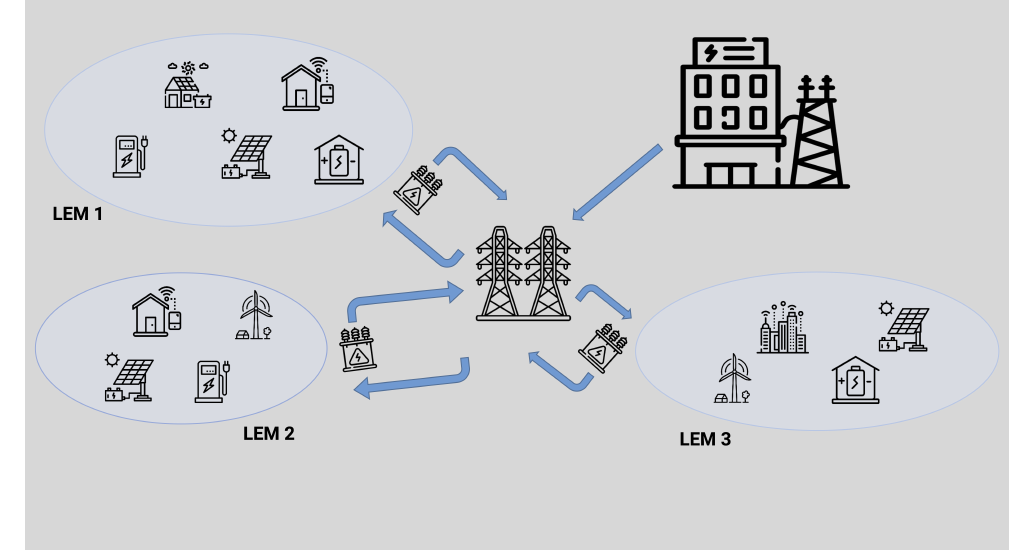
Figure 2. The future decentralized electricity